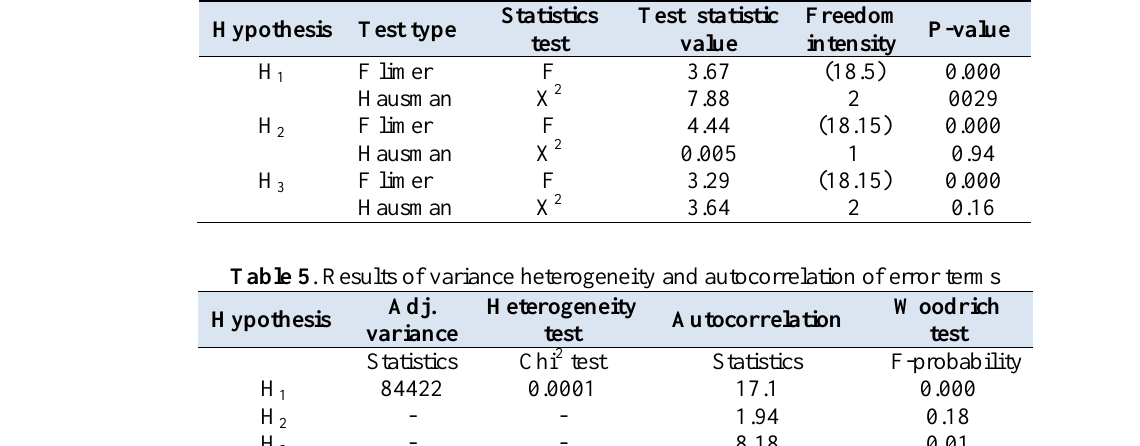
Table 4 . Results of Hausman and F. Limer test